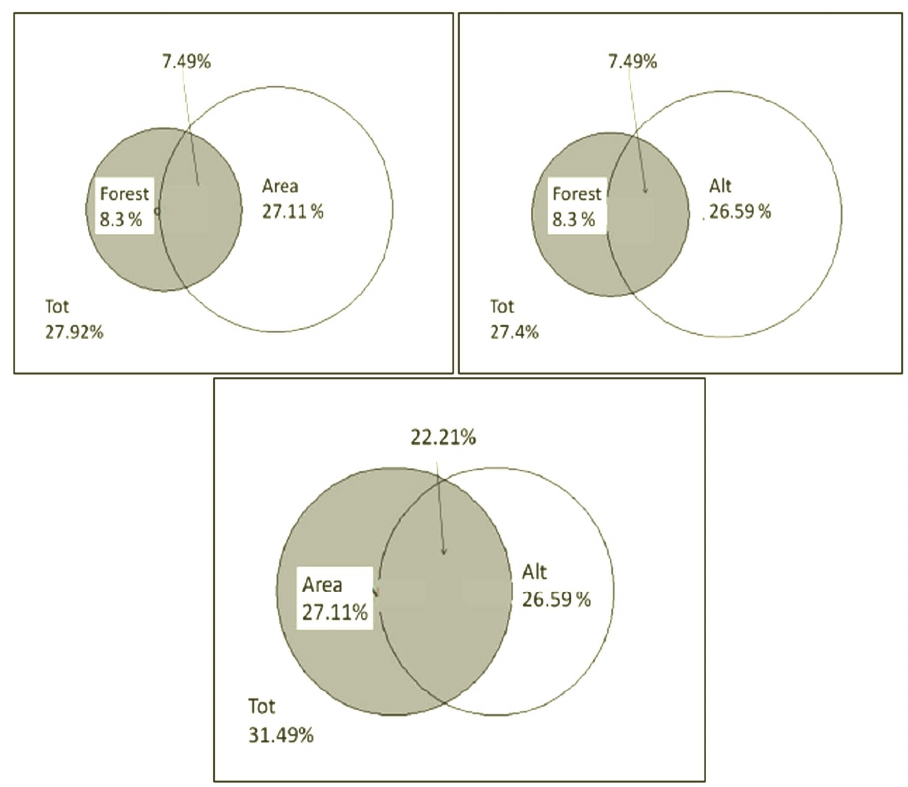
Figure 14. Percentage of variability explained by the pairs of components indicated, in order to identify the shared part of variability. Forest = primary or secondary forest, Alt = elevation levels, Area = Otonga or Otongachi. Model built on presence/absence data.